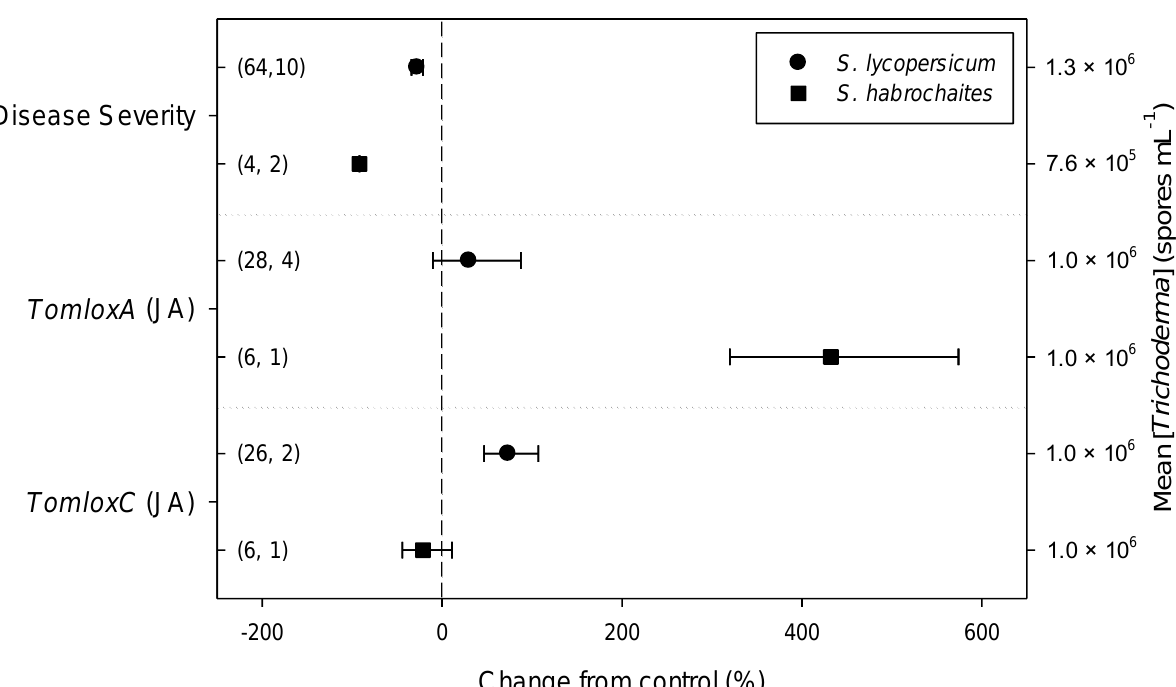
(Figure 5). No differential effects of Trichoderma treatment on disease severity (0–3 vs. 4–7 4 – 7 vs. 8 – 14 DOI), PINI and TomloxA (0 – 3 vs. 4 – 7 DOI) were reported on the basis of du- vs. 8–14 DOI), PINI and TomloxA (0–3 vs. 4–7 DOI) were reported on the basis of duration ration of B. cinerea infection (Table S10). of B. cinerea infection (Table S10).